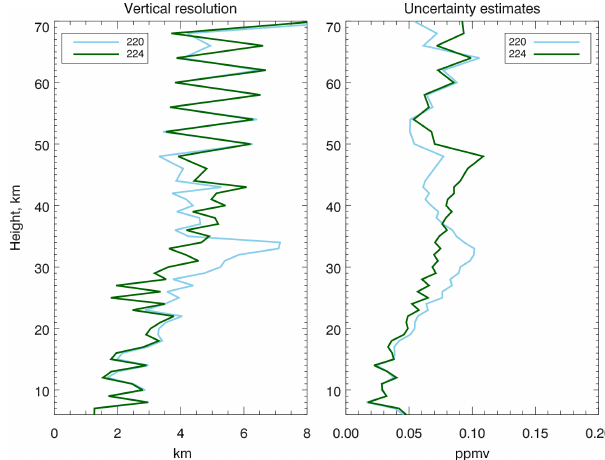
Figure 3. Vertical resolution (left panel) and uncertainty esti- mates (right panel) of MIPAS ozone profiles from the versions V5R_O3_220 (blue lines) and V5R_O3_224 (green lines) on ge- olocation